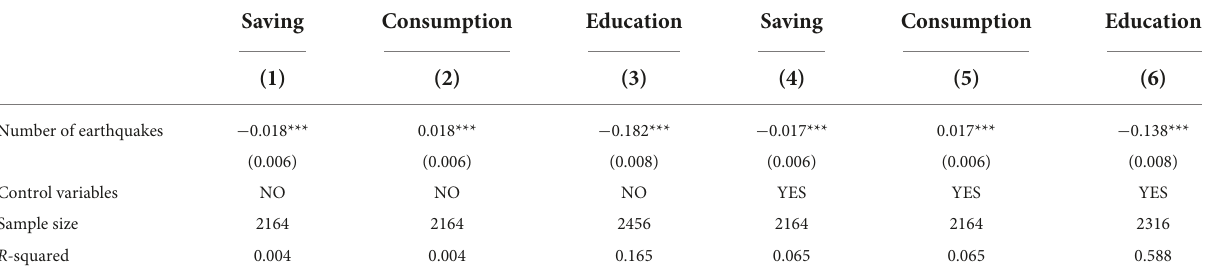
TABLE 2 Effect of earthquakes on time